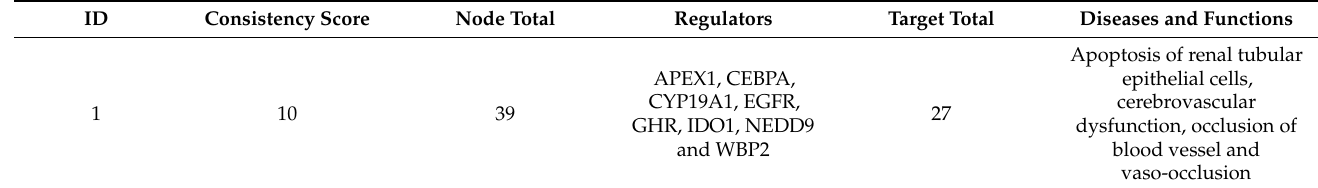
Table 8. Regulators’ effect: list of predicted networks by IPA for w/ TNF α dataset. ID Consistency